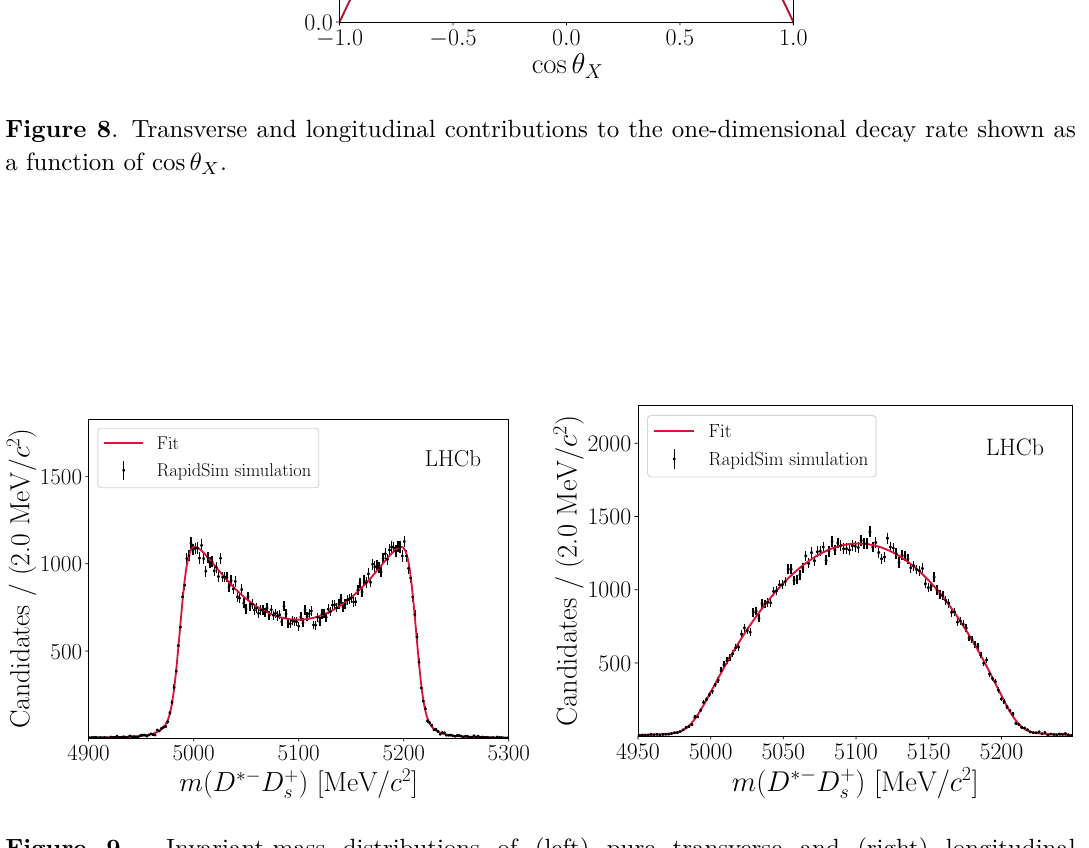
Figure 9 . Invariant-mass distributions of (left) pure transverse and (right) longitudinal B 0 → D ∗− ( D ∗ + → D + γ ) simulated decays. Fits to the distributions are overlaid, from which shape s s parameters for use in the m ( D ∗− D + ) data fit are s